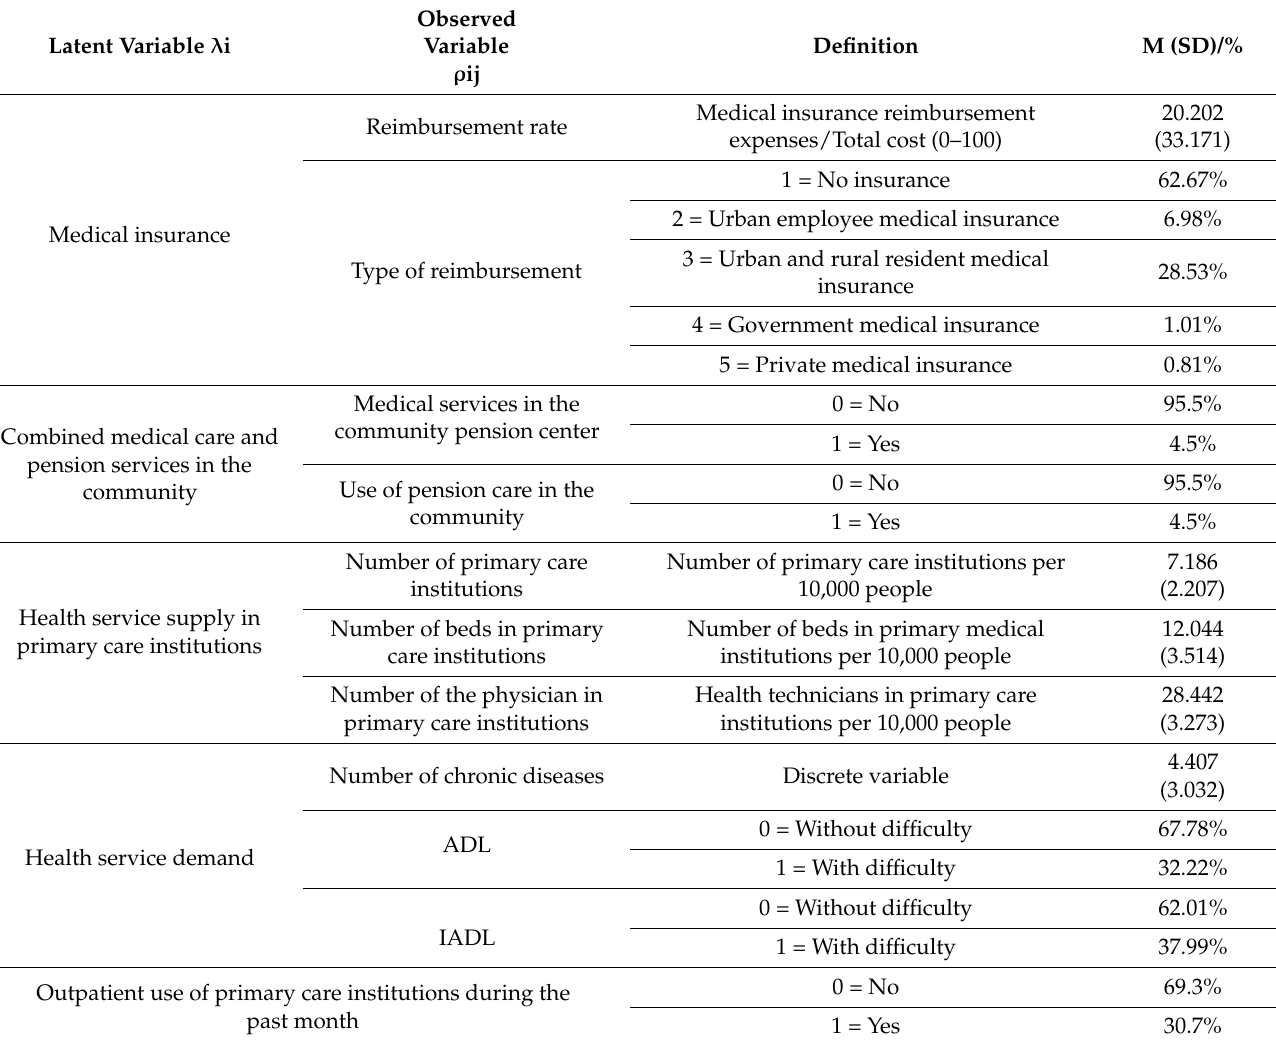
Table 1. Variable descriptive